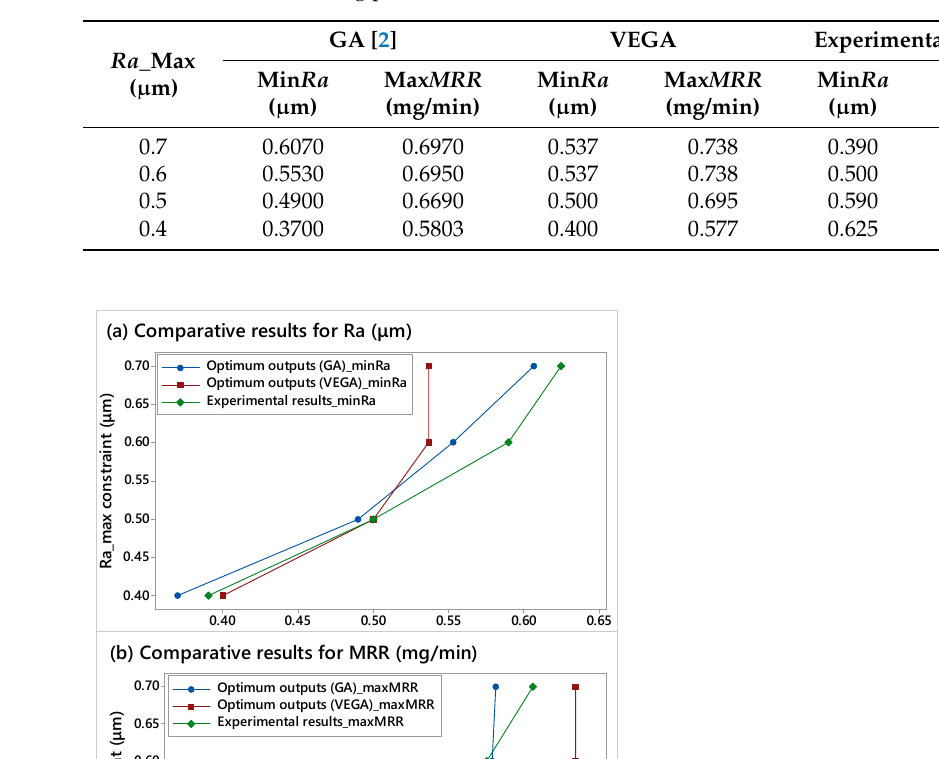
Table 4. Comparison of min Ra and max MRR among genetic algorithm (GA), multi-objective virus- evolutionary genetic algorithm (MOVEGA), and actual experimental results for the conventional abrasive flow nano-finishing process examined in [2].